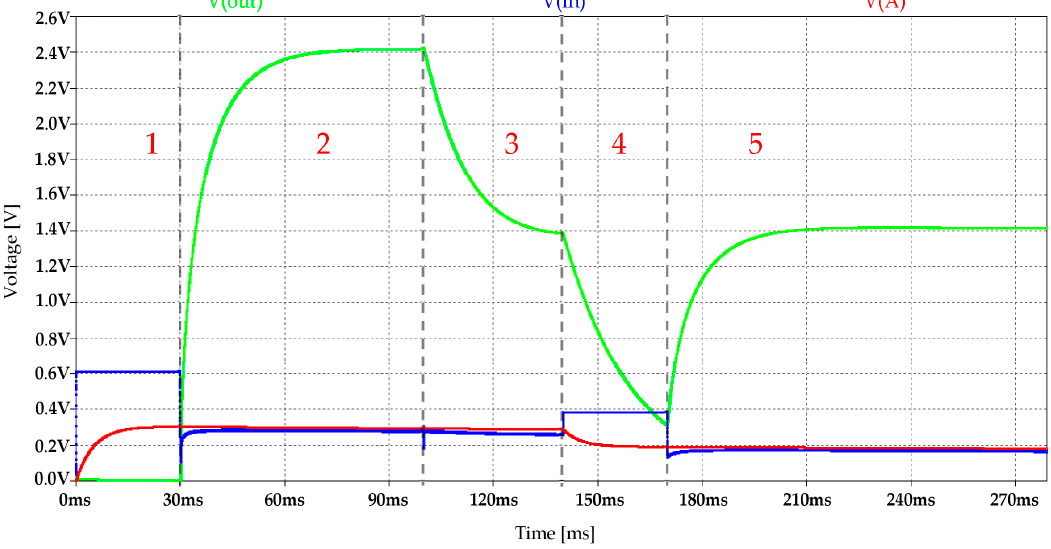
Figure 13. DC/DC converter V OUT (green trace), V IN (blue trace), and V A (red trace) simulation with source temperature difference variation. Region 1: input voltage sensing; Region 2: output voltage regulation; Region 3: temperature difference changing from 16 °C to 10 °C and output lowering; Region 4: new source voltage sensing window and FOCV update; Region 5: output voltage regulation in accordance with the new detected maximum powerpoint.